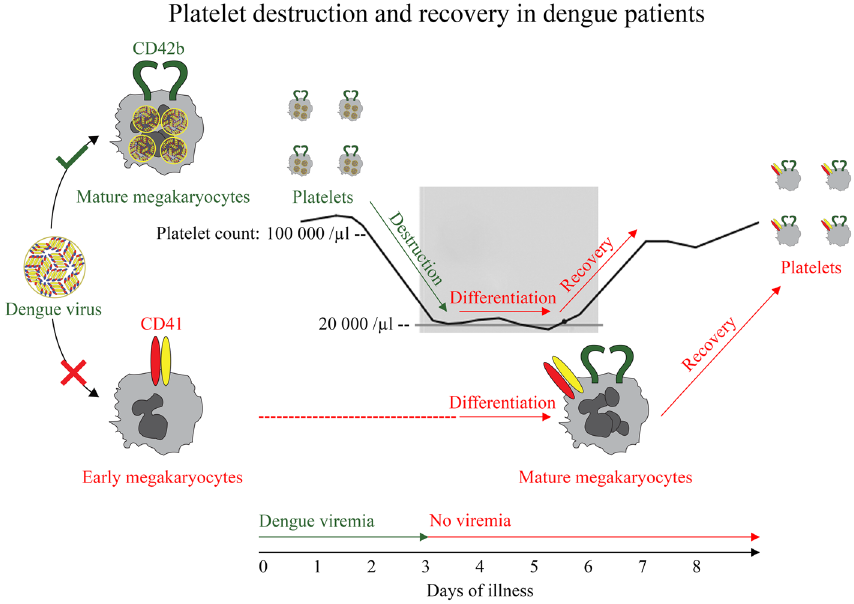
Figure 6. Proposed pathogenesis of platelet destruction and recovery in dengue patients. DENV might attack CD42b + platelets and CD42b + mature megakaryocytes leading to the rapid destruction of platelets. DENV could not attack CD42b − early megakaryocytes explaining the characteristic delay of platelet recovery during the differentiation from early to mature megakaryocytes for 3 days. All new CD42b + megakaryocytes could start producing platelets resulted in the rapid recovery of